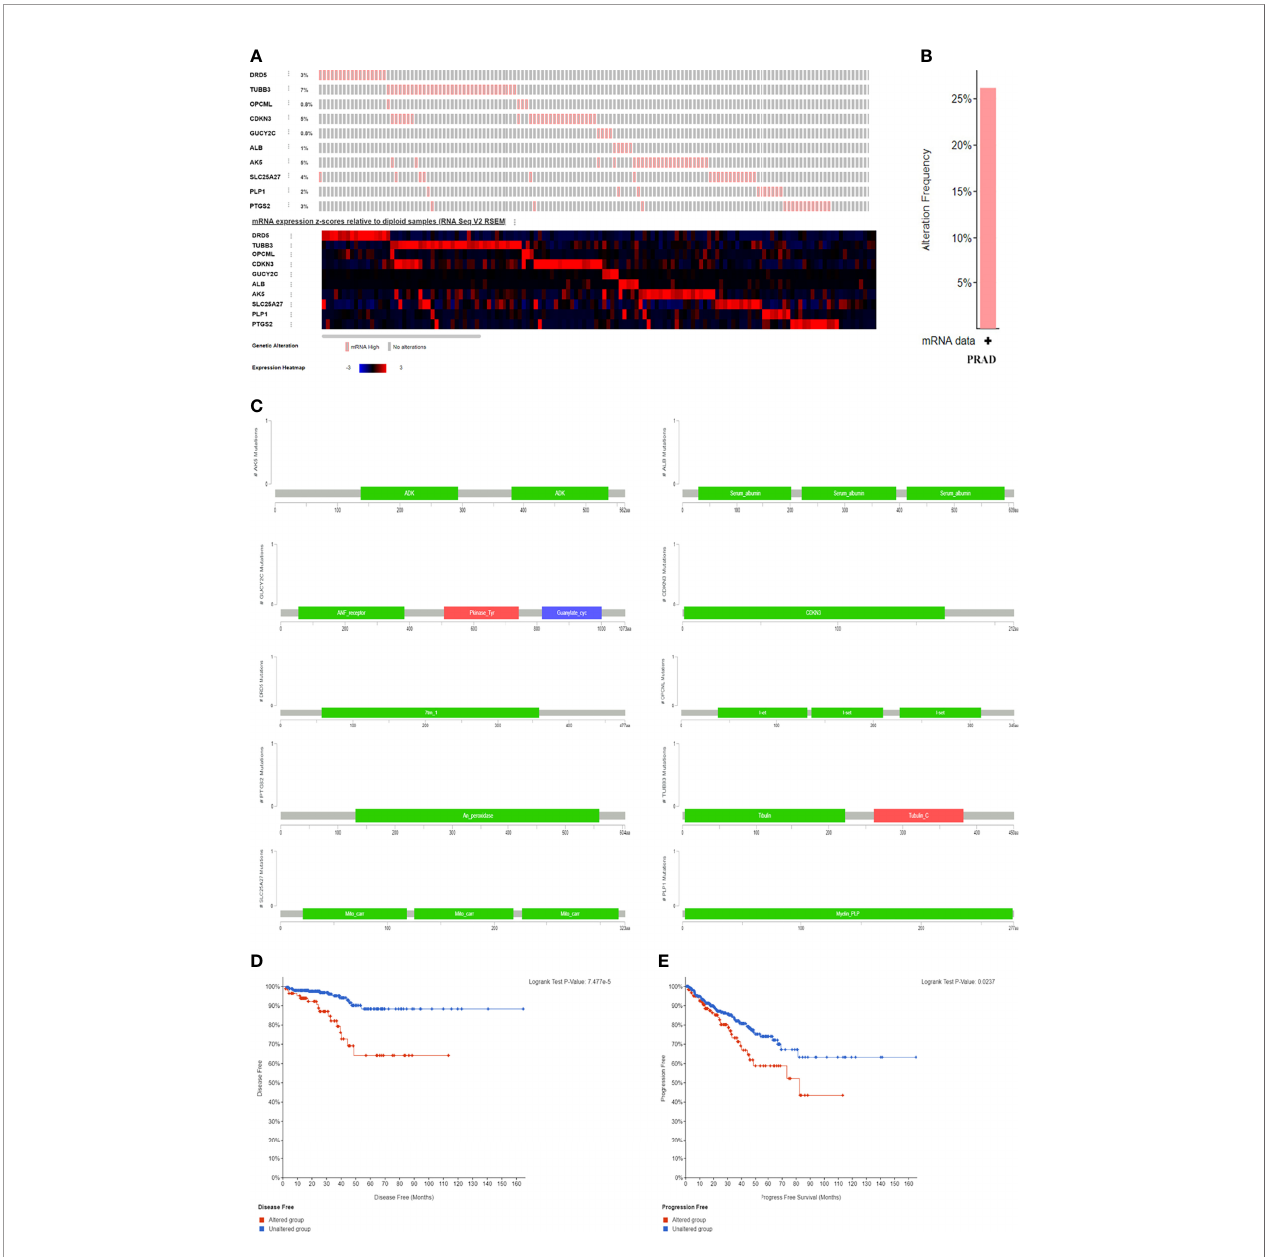
FIGURE 5 | The genomic alterations and survival difference between altered group and unaltered group. (A) the mRNA expression frequency of genes; (B) the alteration frequency in PCA patients; (C) the mutation location of genes; (D) the difference of altered and unaltered group regarding disease free survival; (E) the difference of altered and unaltered group regarding progress free